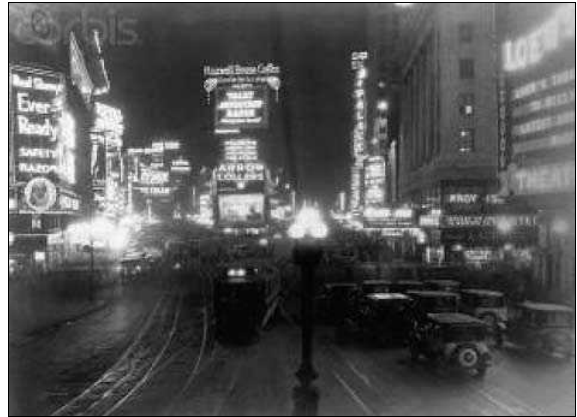
Fig. 10. times Square, New York,